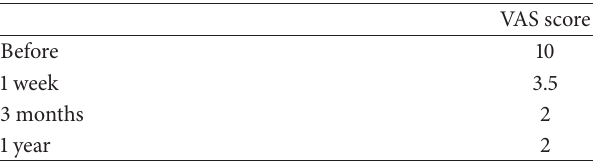
Table 1: VAS scores before and after 1 week and 3, 6 months by the procedure of PVP. Pain relief was rapid and significant immediately after the procedure, starting from 10 preprocedure to stabilization on 2 after three months and 1 year after